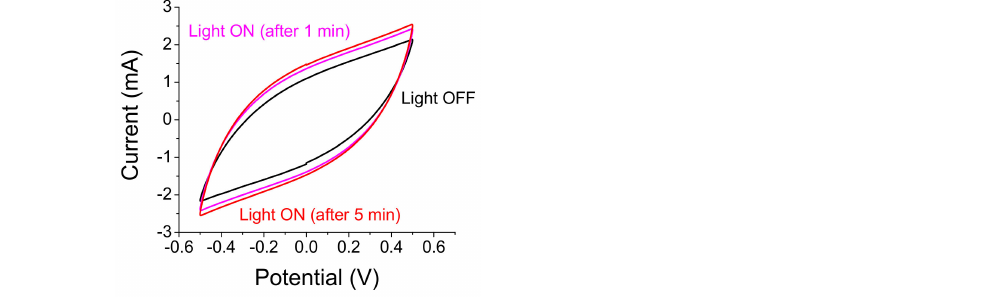
Figure 4. Temporal response of n-Si embedded A-C based S-C. Most of the capacitance increase of 50% occurs within the first min of exposure while a fuller increase of 68% occurs after 5 min.